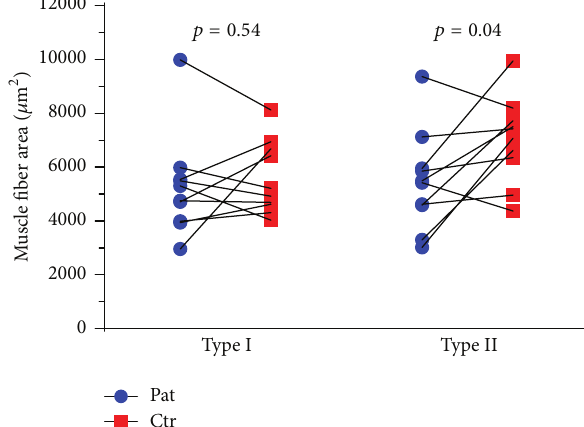
Figure 1: Maximal voluntary contraction (MVC) torque. Measured as isometric contraction of m. quadriceps femoris . Lines drawn signify the pairwise match of patient-control.